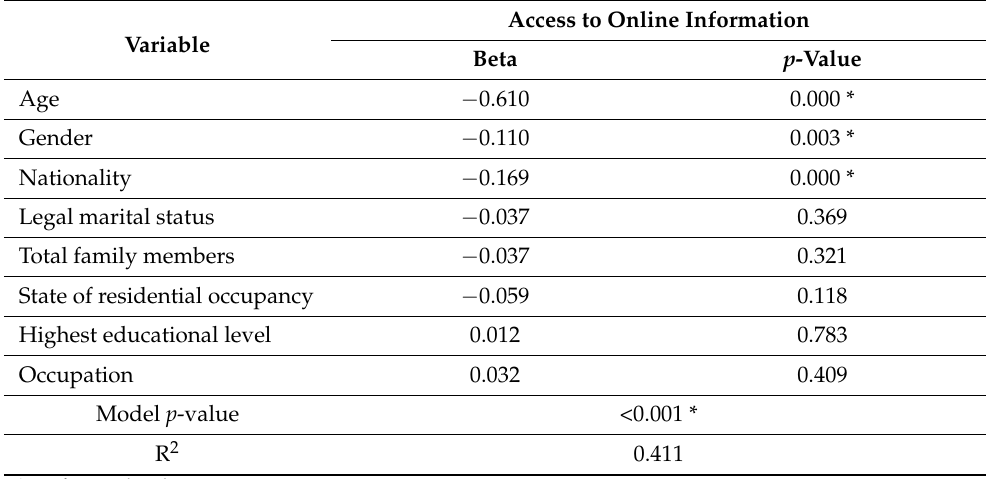
Table 3. Factors influencing urban marginalized people’s access to COVID-19 digital